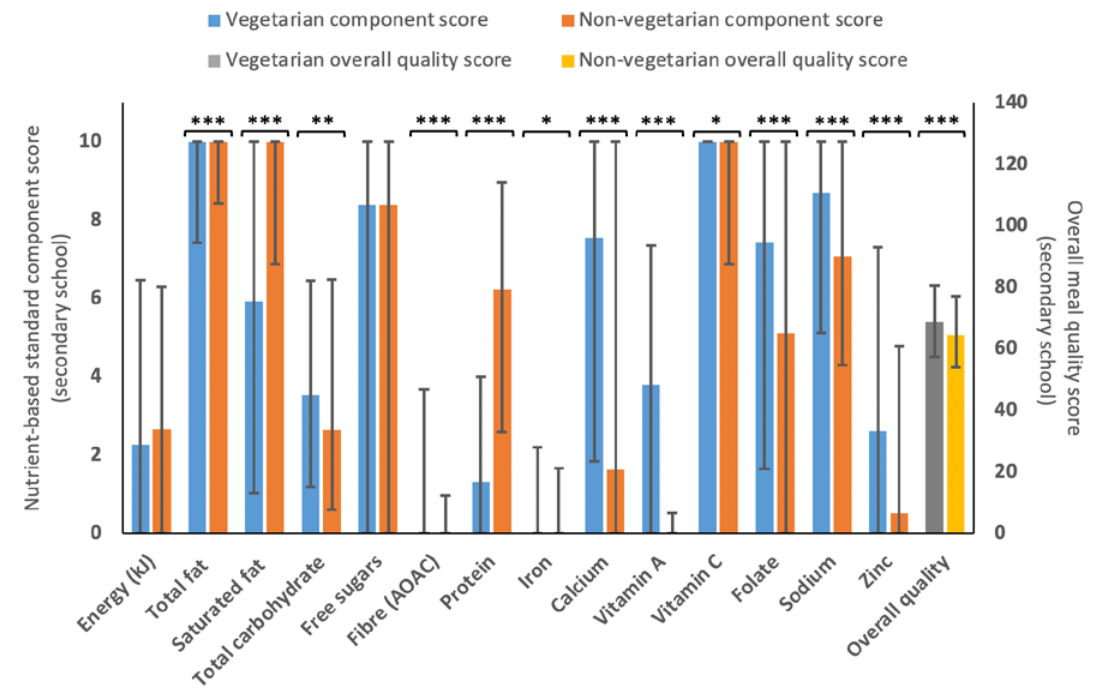
Figure 4. Median (IQR) for the different 11 – 18 years component scores and overall quality score for vegetarian ( n = 1288) and non - vegetarian ( n = 1471) menu variants. A statistically significant difference is represented by * p < 0.05, ** p < 0.01 and *** p < 0.001, as determined by Mann–Whitney U